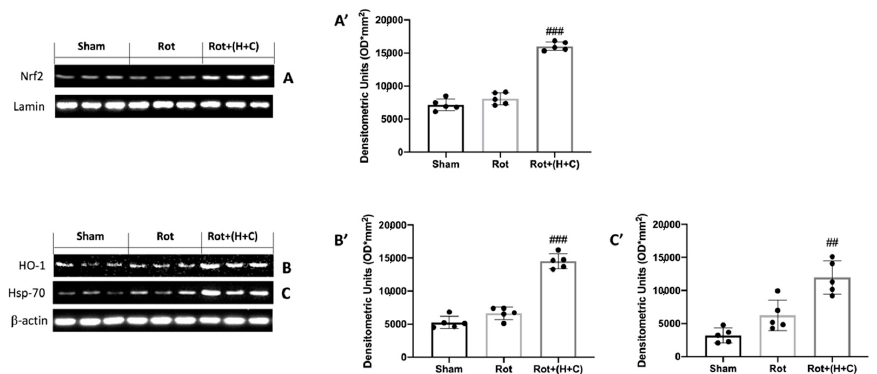
Figure 1. Effects of H+C on Nrf2, HO-1 and Hsp-70 after Rot intoxication. Western blot analysis revealed, compared with Sham group, a slight elevation of Nrf2 ( A ), HO-1 ( B ) and Hsp-70 ( C ) in Rot-treated mice. Animals subjected to treatment with H+C revealed a significant increase in these proteins. See the respective densitometric graphs ( A’ , B’ , C’ ). Values are expressed as mean ± SD of three independent analyses on 5 animals/group. ## p < 0.01 compared to Rot; ### p < 0.001 compared to Rot.